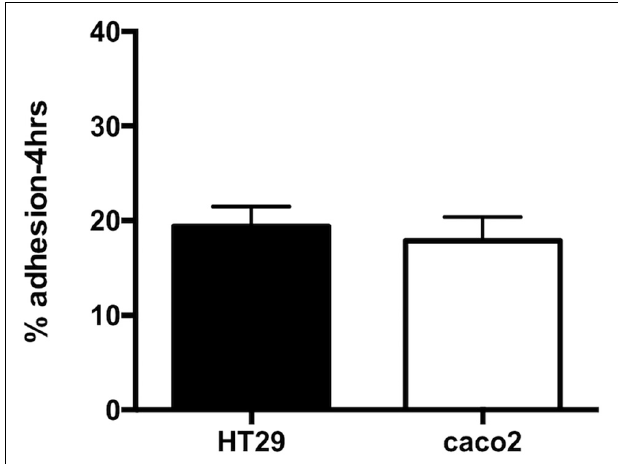
FIGURE 2 | Data represents percentage of adhesion of R. badensis subsp. acadiensis to HT29 and Caco2 cells. Results shown are means of three independent experiments ±